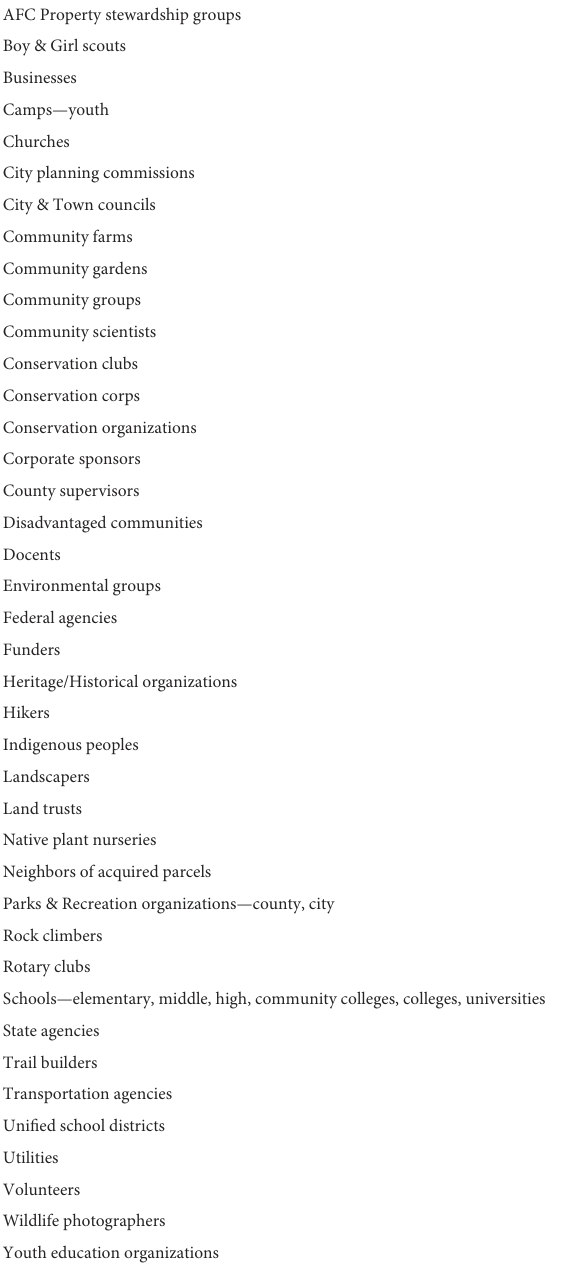
TABLE 3 List of stakeholders invited to participate in urban wildlife corridor conservation.